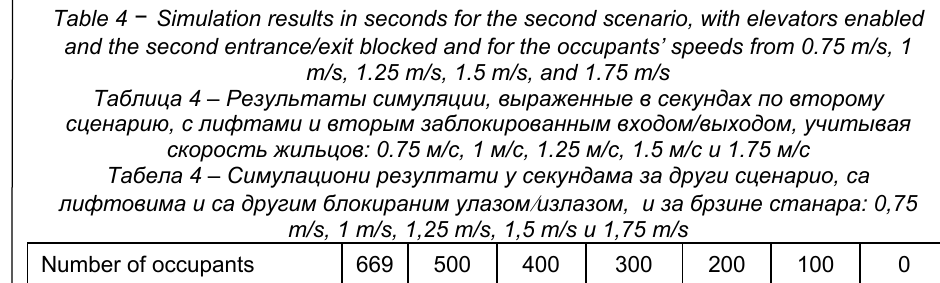
Table 4 – Simulation results in seconds for the second scenario, with elevators enabled and the second entrance/exit blocked and for the occupants’ speeds from 0.75 m/s, 1